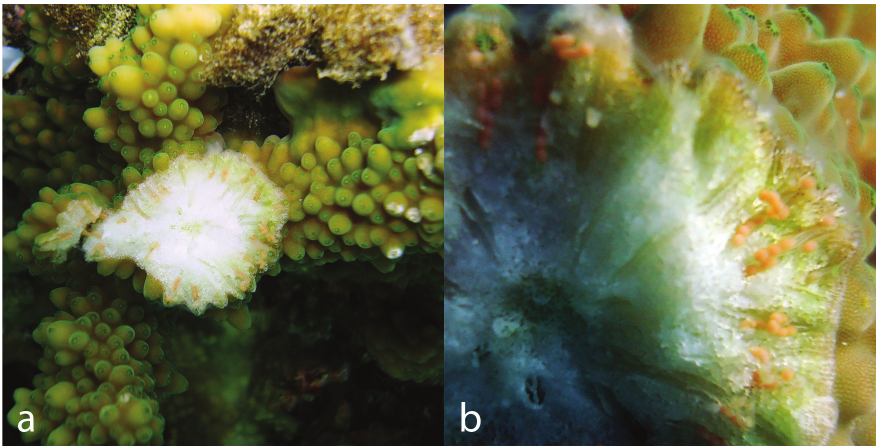
Figure 2. a Exposed oocytes in a mature colony of Acropora variolosa b close-up of pigmented